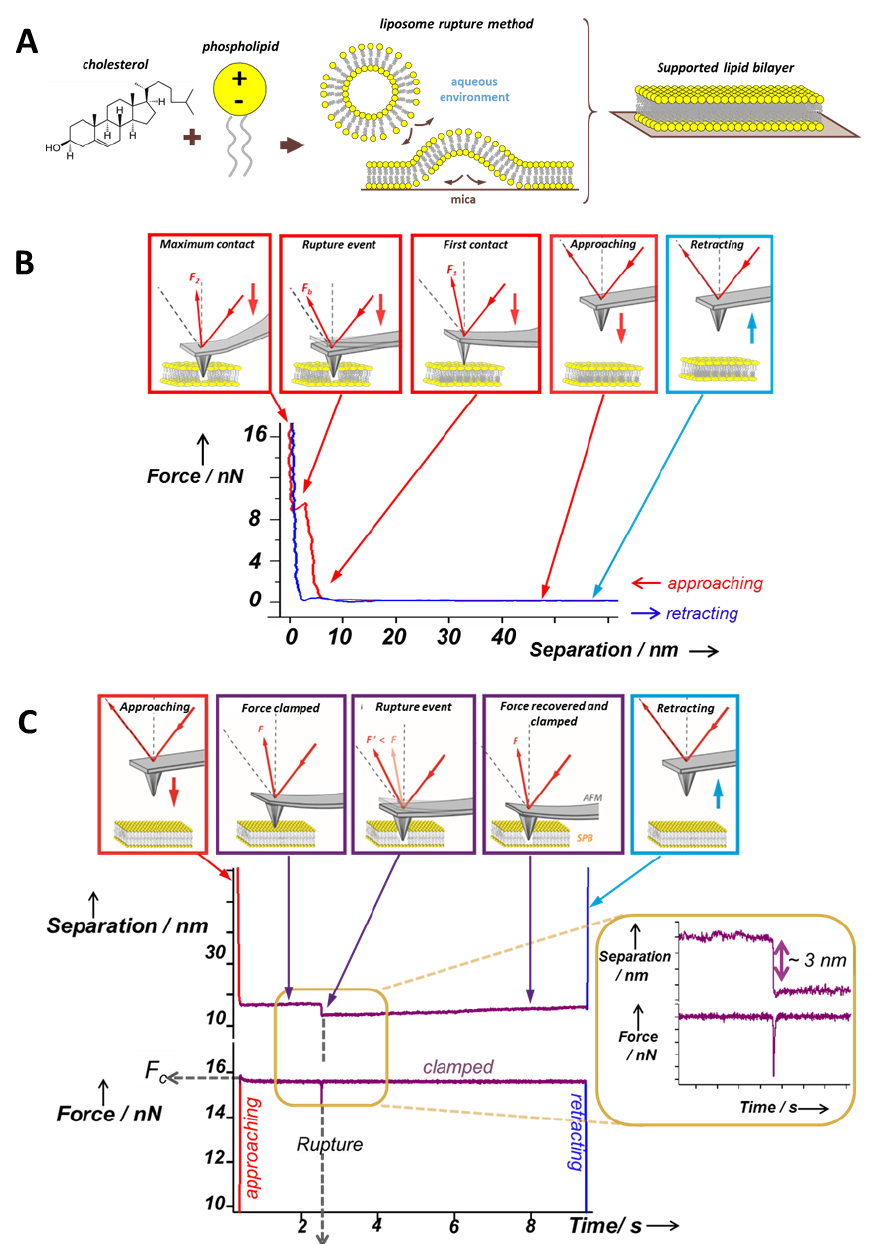
Figure 1. ( A ) Schematic diagram showing the formation of SLBs via the liposome rupture method; ( B ) schematics of the SLB indentation process using AFM-based force spectroscopy (AFM-FS), displaying a force–separation typical curve, showing the discontinuity in the approach curve when the bilayer is punctured. The different steps in the scheme and the corresponding part of the force curve are linked by arrows. ( C ) Schematics of the SLB indentation process under constant force: AFM-based force clamp (AFM-FC), displaying separation-time and force-time typical curves, showing the bilayer rupture event. The different steps in the scheme and the corresponding part of the curves are linked by arrows. Adapted with permission from ref. [24]. Copyright 2012 American Chemical Society.